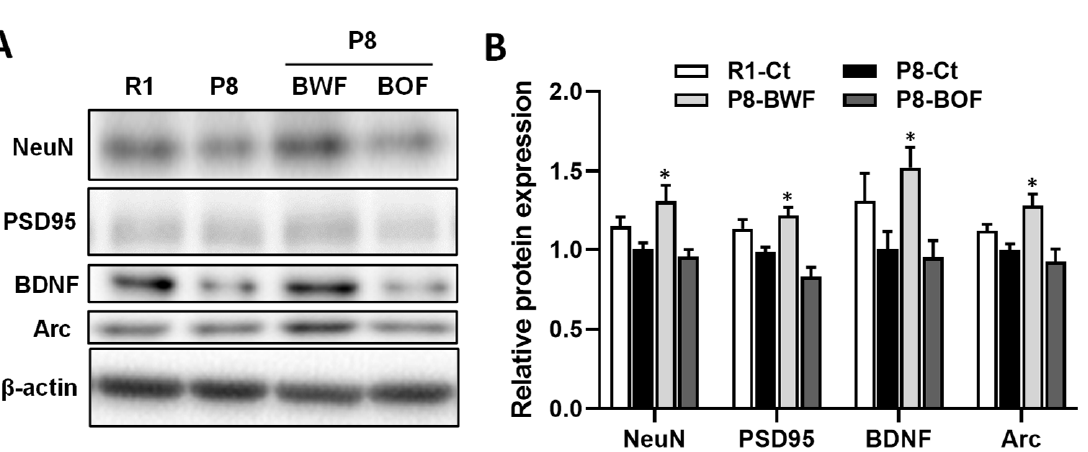
Figure 3. Effects of oral administration of buckwheat flours on protein expression levels in the hippocampus of SAMP8. ( A ) Representative image of the Western blot. β -actin was used as internal control. ( B ) Densitometric analysis of the band was expressed as relative fold compared with that in the P8-Ct group. Data are presented as the mean ± standard error of mean ( n = 5). * p < 0.05, compared with the P8-Ct group. NeuN, neuronal nuclear antigen; PSD95, postsynaptic density protein 95; BDNF, brain-derived neurotrophic factor; Arc, activity-regulated cytoskeleton-associated protein.